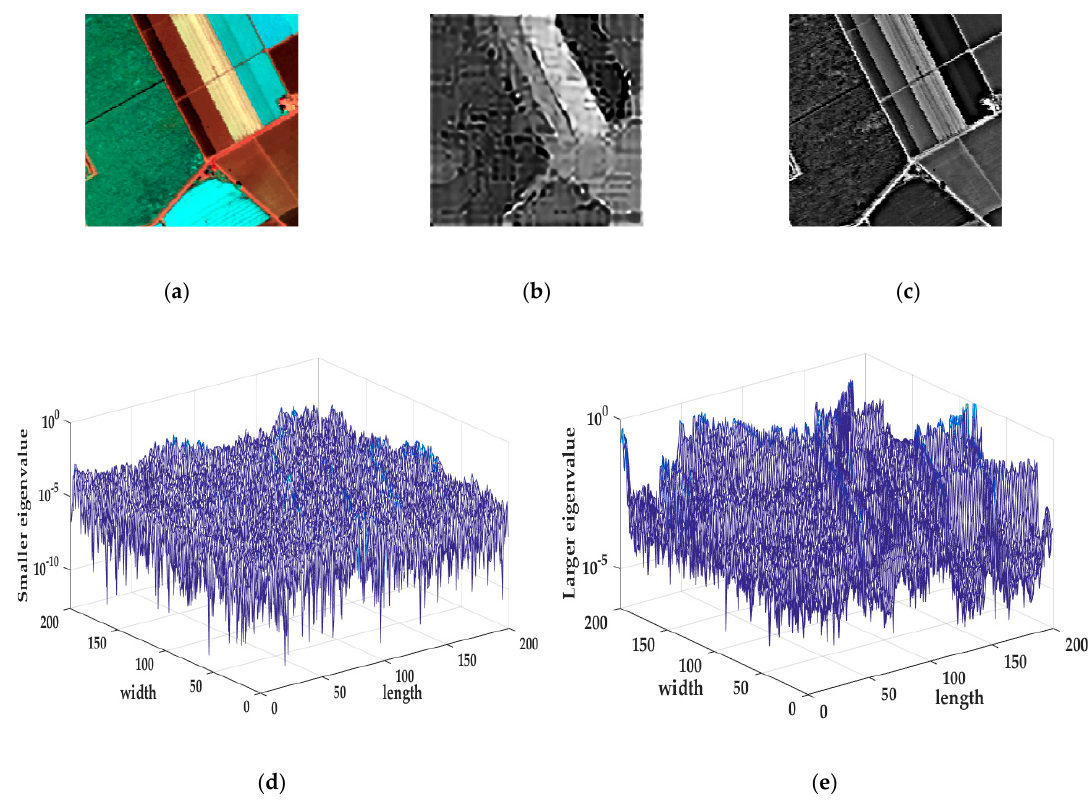
Figure 4. Two eigenvalues at each pixel of the weighted tensor matrix. ( a ) Salinas scene hyperspectral image; ( b )Spatialinformationofthehyperspectralimage I HR ; ( c )EnhancedPANimage I PAN s ; ( d )Smaller eigenvalue; ( e ) Larger eigenvalue.